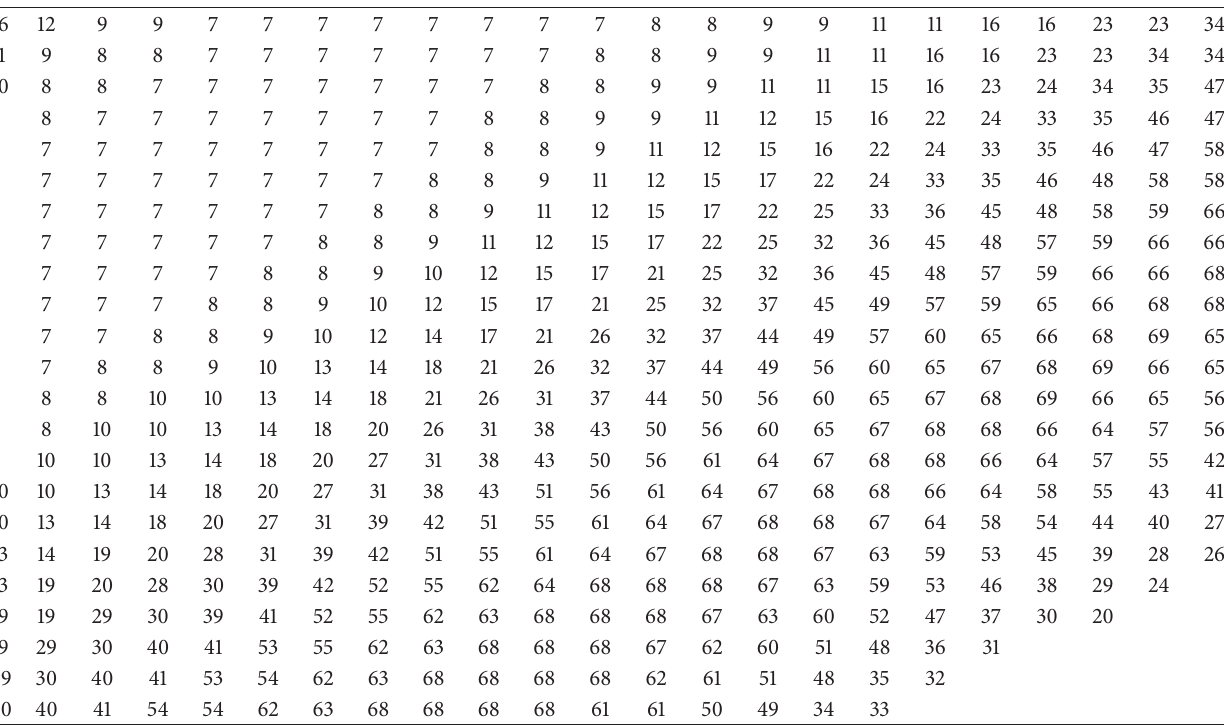
Table 2: The quantization value on each frequency order for